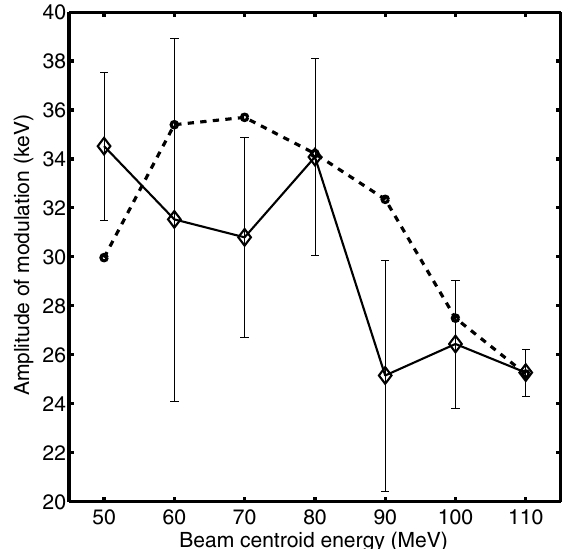
FIG. 5. Measured dependence of the energy modulation am- plitude on beam centroid energy. The dashed curve is the simulation result of space-charge induced energy modulation with about (cid:9) 3% of initial density modulation at the measured modulation